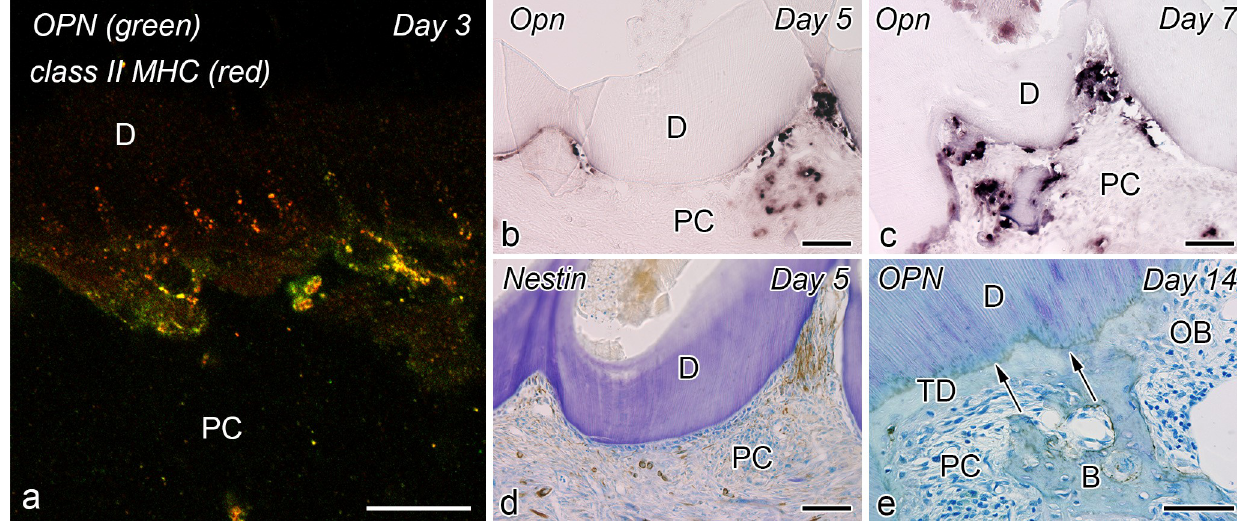
Figure 6. Relationship between OPN and DCs during pathological dentinogenesis (cited from Saito et al. [49], with permission from SAGE). ( a ) OPN and MHC class II double immunofluorescence staining. ( b , c ) OPN in situ hybridization and immunohistochemistry for ( d ) nestin and ( e ) OPN on day 3 ( a ), day 5 ( b , d ), day 7 ( c ), and day 14 ( e ) after tooth allogenic tooth transplantation. ( a ) MHC + Class II cells (red) with dendritic features are also positive for OPN (green) on day 3 after transplantation, indicating that OPN + cells are immunocompetent cells, such as macrophages and DCs. ( b , c ) Intense OPN reactions are seen at the mineralization front of the preexisting dentin on day 5. Opn mRNA + cells are recognized at the pulp-dentin border in days 5 and 7. ( d ) Nestin-positive newly-differentiated odontoblast-like cells are arranged along the pulp-dentin border where OPN + cells had previously existed. ( e ) Two weeks after the operation, OPN immunoreactions are observed at the boundary between the predentin and the newly-formed dentin matrix (arrows). OPN + osteoblasts surround the bone matrix. B bone, D dentin, OB odontoblasts, PC pulp cavity, TD tertiary dentin, Bar = 100 µ m ( c , d , e ), 50 µ m ( e ), 10 µ m ( a